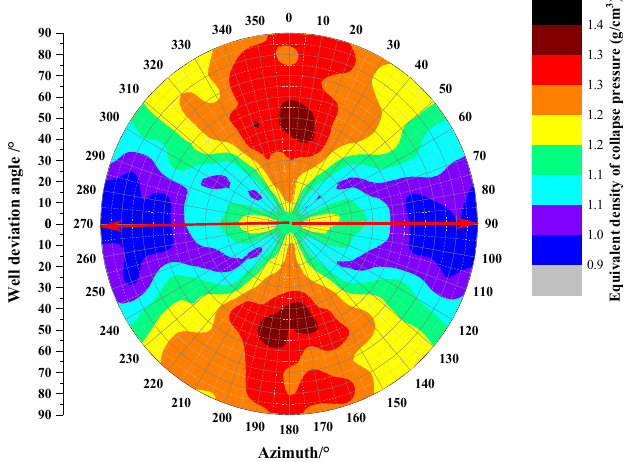
Figure 9. Under strike-slip fault condition ( σ H > σ V > σ h ). Figure 10 shows the variation law of collapse pressure equivalent density with well inclination and azimuth under reverse fault condition ( σ H > σ h > σ V ). The maximum collapse density can reach 1.40 g/cm 3 and the minimum is 0.95 g/cm 3 . The collapse density values at azimuth angles of 50 ◦ ~130 ◦ and 230 ◦ ~310 ◦ corresponding to well deviation angles of 0~90 ◦ are low, and drilling along this direction is the safest under the condition of this study.